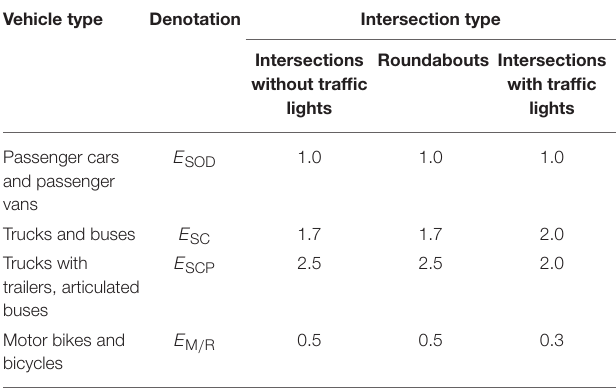
TABLE 3 | Passenger car equivalent factors values according to Polish